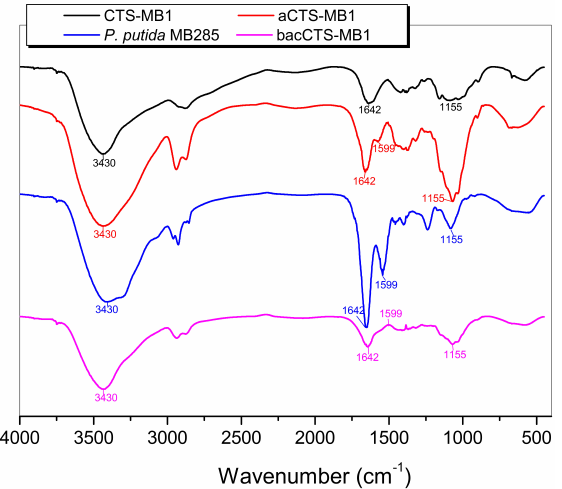
Figure 3. FT-IR spectra for P. putida MB285 cells and the as-prepared CTS-MB1s, aCTS-MB1s and